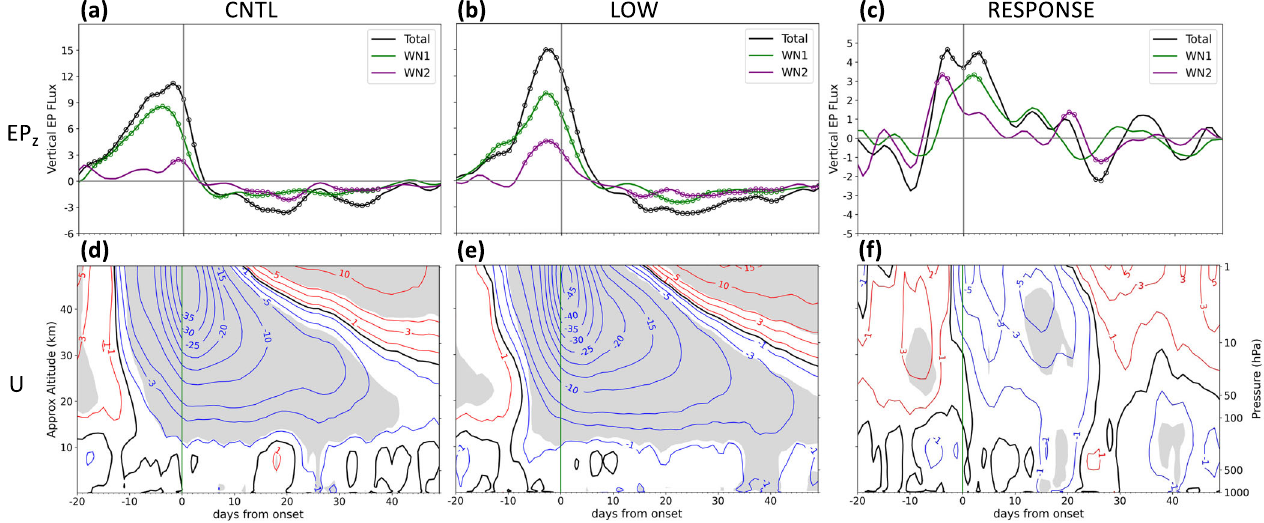
Fig. 3 Composite zonal-mean zonal wind (U) and vertical EP Flux component (EP z ) during SSW. The time series of 100-hPa EP z anomaly (averaged in 45°N – 75°N), along with their decomposition in zonal wavenumbers 1 and 2 ( a – c ; in 10 − 2 m 2 s − 2 ), along with the time ‐ height cross-section of 60°N U anomaly ( d – f ; in m s − 1 ). The left column corresponds to the CNTL experiment, the middle column LOW experiment, and the right column the response (i.e., LOW-CNTL). Open circles ( a – c ) and gray shading ( d – f ) indicate statistical signi fi cance at the 95% level.